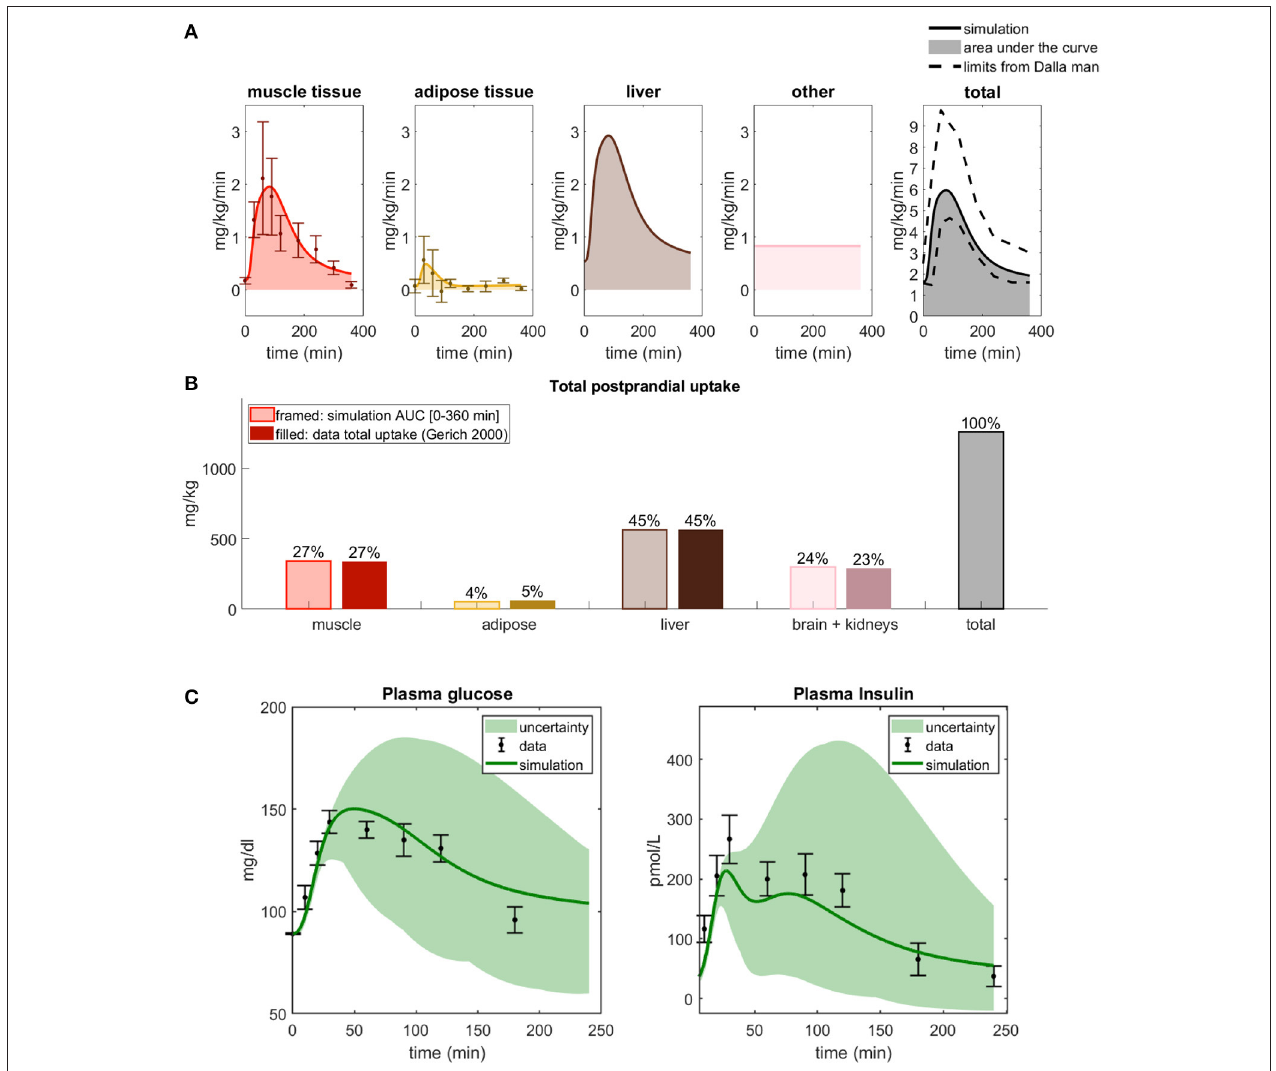
FIGURE 5 | The behavior of the final updated multi-level model. (A) Simulations of glucose uptake in all organs and tissues and time-series for the data used to fit the model ( Coppack et al., 1996). The total glucose uptake is within the bounds presented in Dalla Man et al. (2007). (B) Total glucose uptake for all organs, simulated by the final model and from the data used to fit the model (Coppack et al., 1996). (C) Simulations of plasma glucose and insulin compared with independent data from Adams et al. (2018). The green line represents the parameter set with the best fit to validation